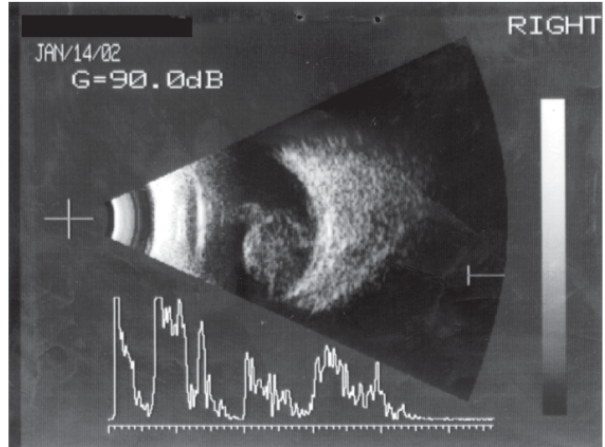
Figure 1 - Case 2 echography: Closed funnel retinal detachment and the presence of a solid lesion in the temporal sector with a diameter of approximately 8 mm, with low to moderate internal reflectivity forming the angle kappa